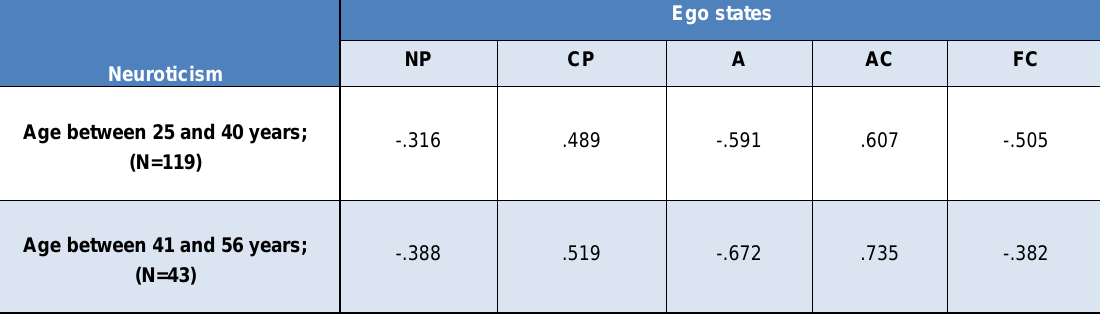
Table 4: Correlations between ego states and Neuroticism (By